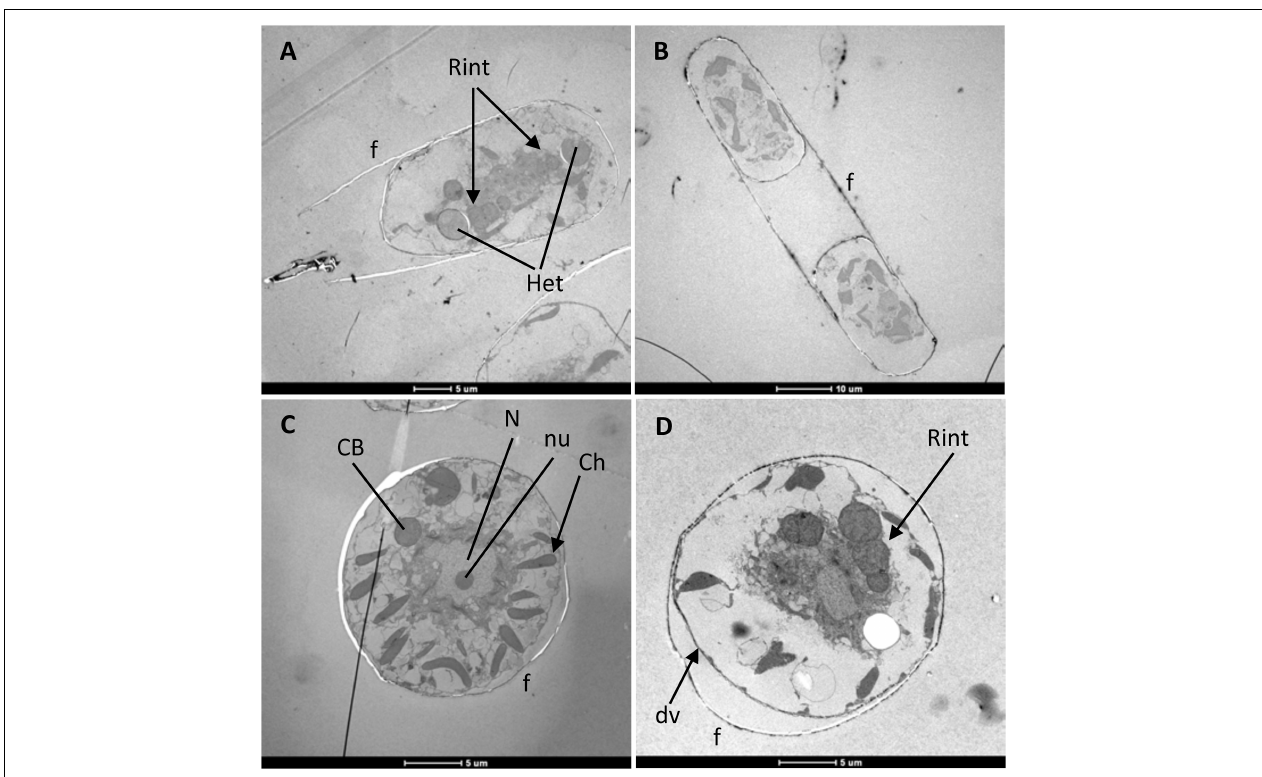
FIGURE 2 | Transmission electron micrographs of H. hauckii . Longitudinal sections of a single cell (A) or of a pair of cells (B) and transverse sections of single cells (C,D) can be observed. Filaments of R. intracellularis (Rint) can be seen in panels (A,D) (Het, heterocyst), and a transverse section of a cyanobacterial cell (CB) can be seen in (C) (this cell is likely a vegetative cell of a R. intracellularis filament). Additionally, some diatom structures are evident: frustules (f) can be seen as the outermost layers in the cells of the four micrographs, a developing valve can be seen in the lower left part of the cell in panel (D) (dv), and the nucleus (N), including the nucleolus (nu), and several chloroplast lobes (Ch) are evident in the diatom cell in panel (C) .